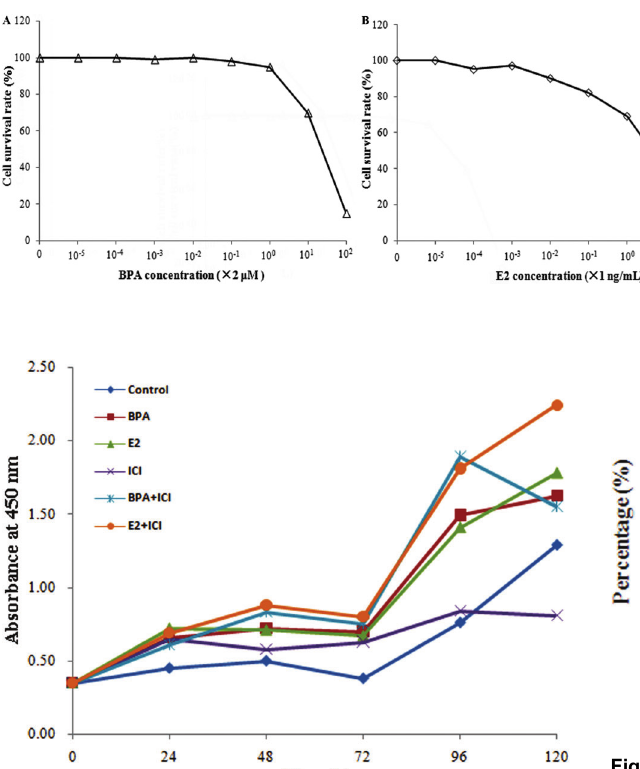
Figure 4. Effect of bisphenol A (BPA) and estradiol (E2) on the HepG2 cell cycle distribution. Data are reported as means ±